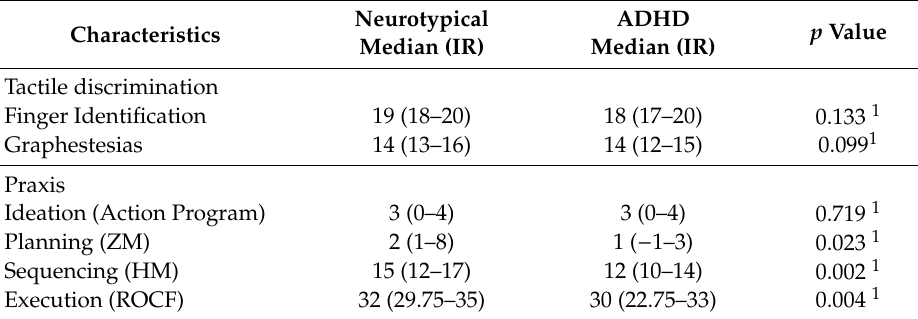
Table 2. Di ff erences between groups in tactile discrimination and praxis.